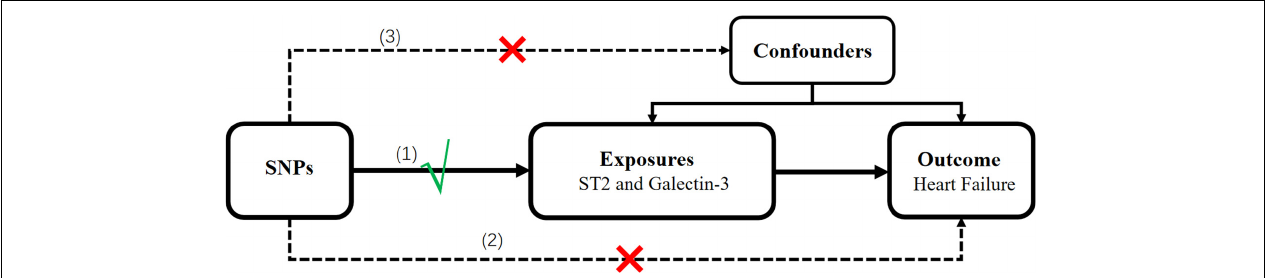
FIGURE 1 | Schematic representation of the MR analysis in this study. Three assumptions of MR analysis are as follows: (1) SNPs must be associated with the ST2 and galectin-3, (2) SNPs not directly be associated with heart failure, and (3) SNPs must not be associated with any confounding factor. MR, Mendelian randomization; SNPs, single-nucleotide polymorphisms.